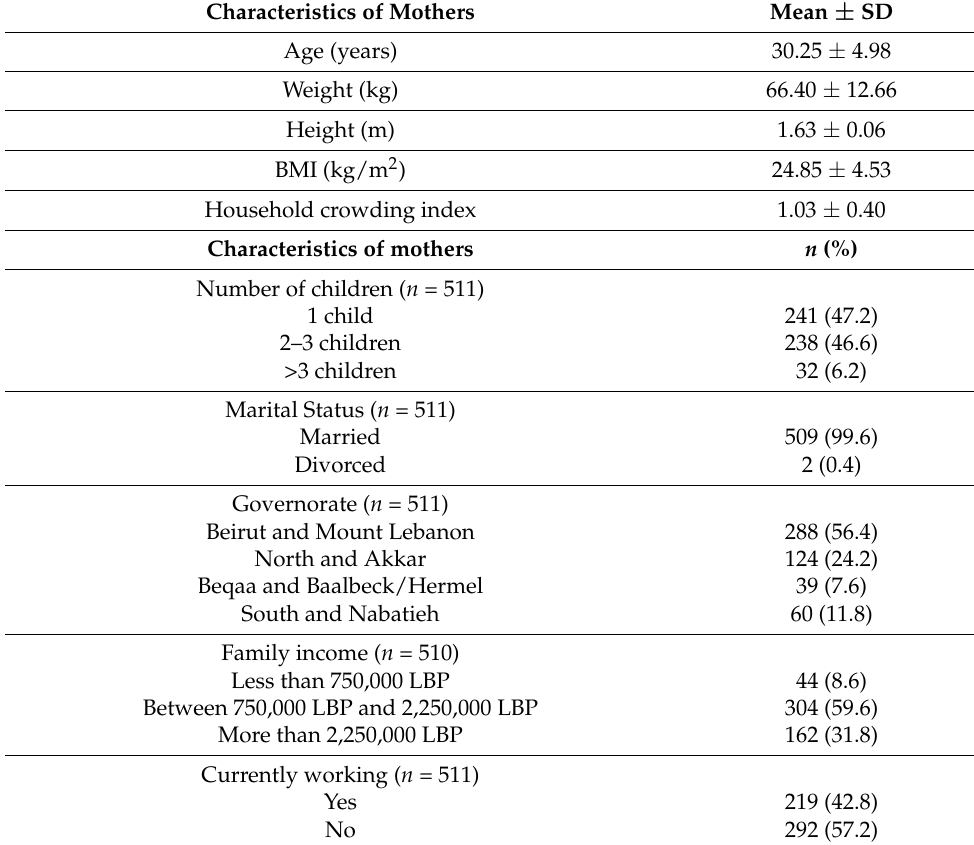
Table 1. Characteristics of the mothers in this